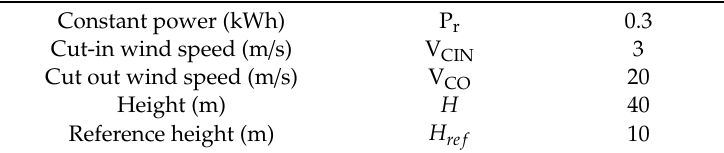
Table 4. Maim input data used in the wind turbine simulation